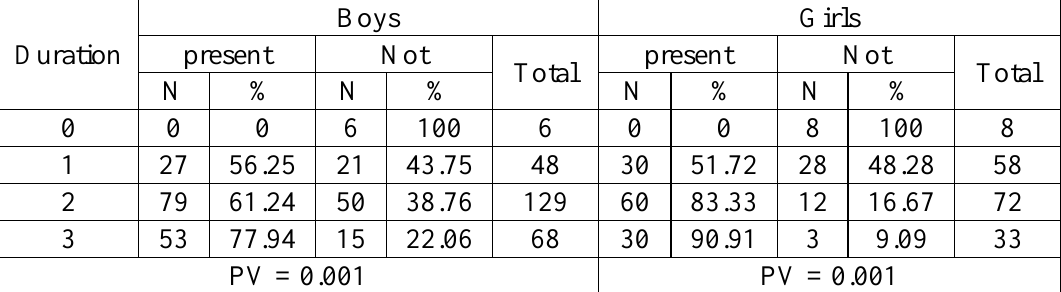
Table 7 : the association between the duration of breast feeding and the presence of ideal primary dentition overbite